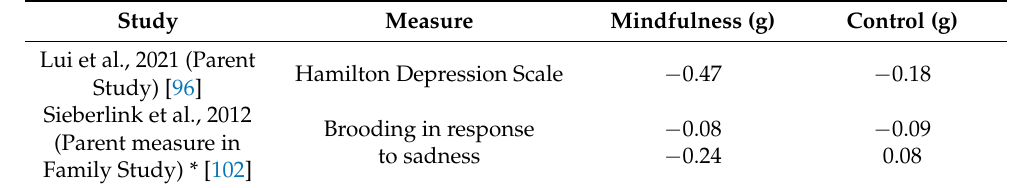
Table 5. The effect sizes from measures of depression used in single studies.